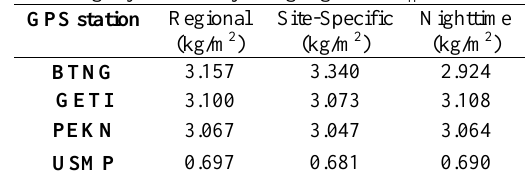
Table 8: Comparison between regional and site-specific T M model. The RMSE from both models have no significant